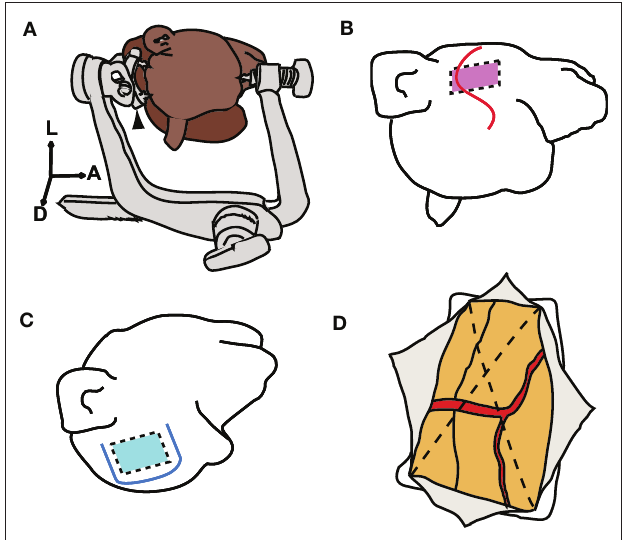
FigurE 1 | Skull fixation and craniotomy. (A) Illustration of head positioning with a three-point fastening device. Black arrowhead indicates a customized attachment for macaques. A, anterior; L, left; D, dorsal. (B) S-shaped skin incision indicated by red line. Red rectangle indicates the range of the craniotomy for the superior temporal sulcus (STS). (C) U-shaped skin incision indicated by blue line. Blue square indicates the range of craniotomy for the central sulcus (CS). (D) Dural incision (dotted lines) into four quadrants. Each quadrant was retracted toward the margin of